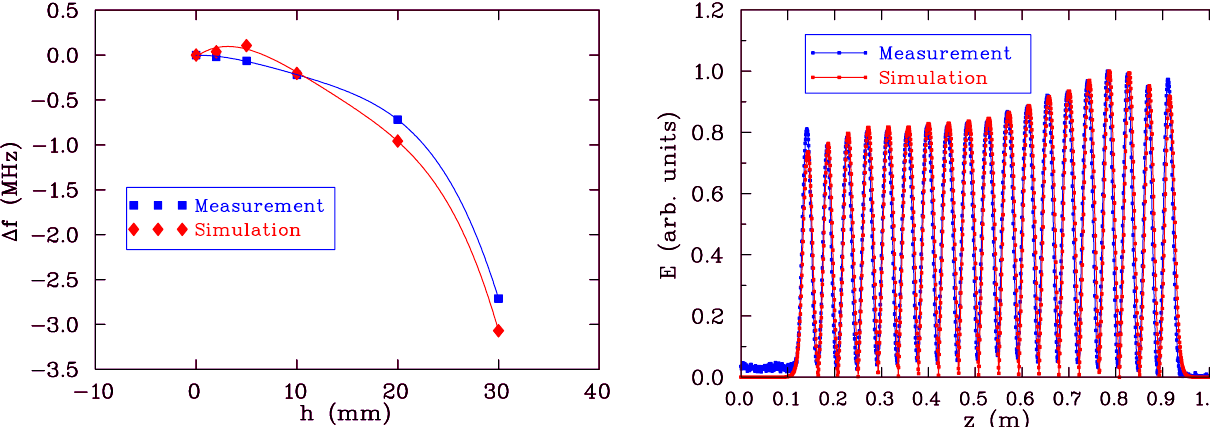
FIG. 23. (Color) Using different heights for the tuners, it was possible to change the field distribution in a well-defined way. Here only 3 tuners with a height of 30 mm have been installed at the right